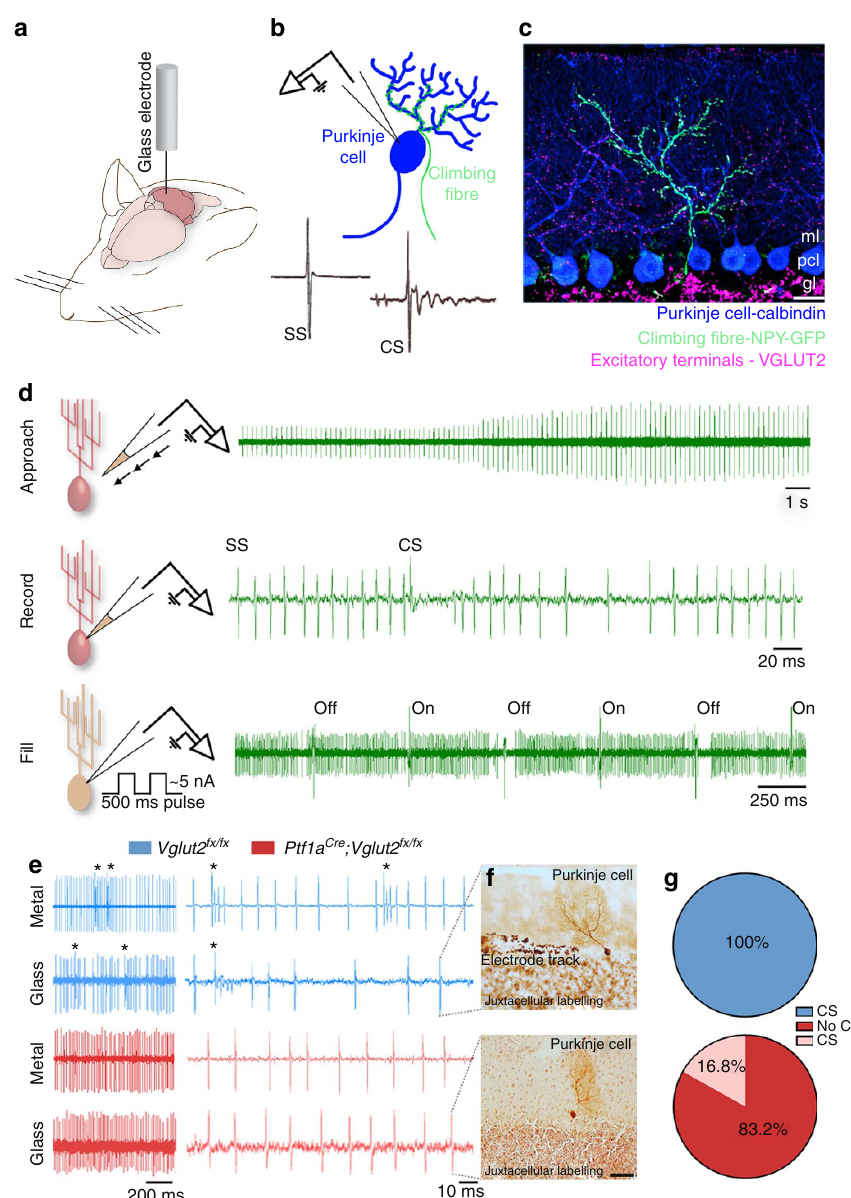
Figure 2 | Loss of VGLUT2 eliminates climbing fibre-driven complex spikes. ( a ) A schematic showing a cerebellar recording in an anaesthetized mouse. Schematic adapted with permission, from drawings published in ref. 28. ( b ) A schematic depicting a single-unit recording from a Purkinje cell with its climbing fibre. Samples of a simple spike (SS) and a climbing fibre-driven complex spike (CS) are shown. ( c ) Molecular expression showing the one-to-one relationship between a climbing fibre and a Purkinje cell with VGLUT2 marking the climbing fibre terminals. Scale bar, 20 m m. ( d ) A schematic of the juxtacellular labelling process. Current pulses are used to find cells based on increased resistance. Once a cell is found, the recording step begins by loosely patching on the membrane of the cell, and recording its extracellular spiking activity. After recording for a sufficient period of time, the cell is filled by delivering neurobiotin using 500ms pulses of positive current between 1 and 5nA for B 1h. Schematic adapted with permission, from drawings published in ref. 74. ( e ) Examples of traces from 3-month-old adult Vglut2 fx/fx and Ptf1a Cre ;Vglut2 fx/fx Purkinje cells either using metal electrodes for